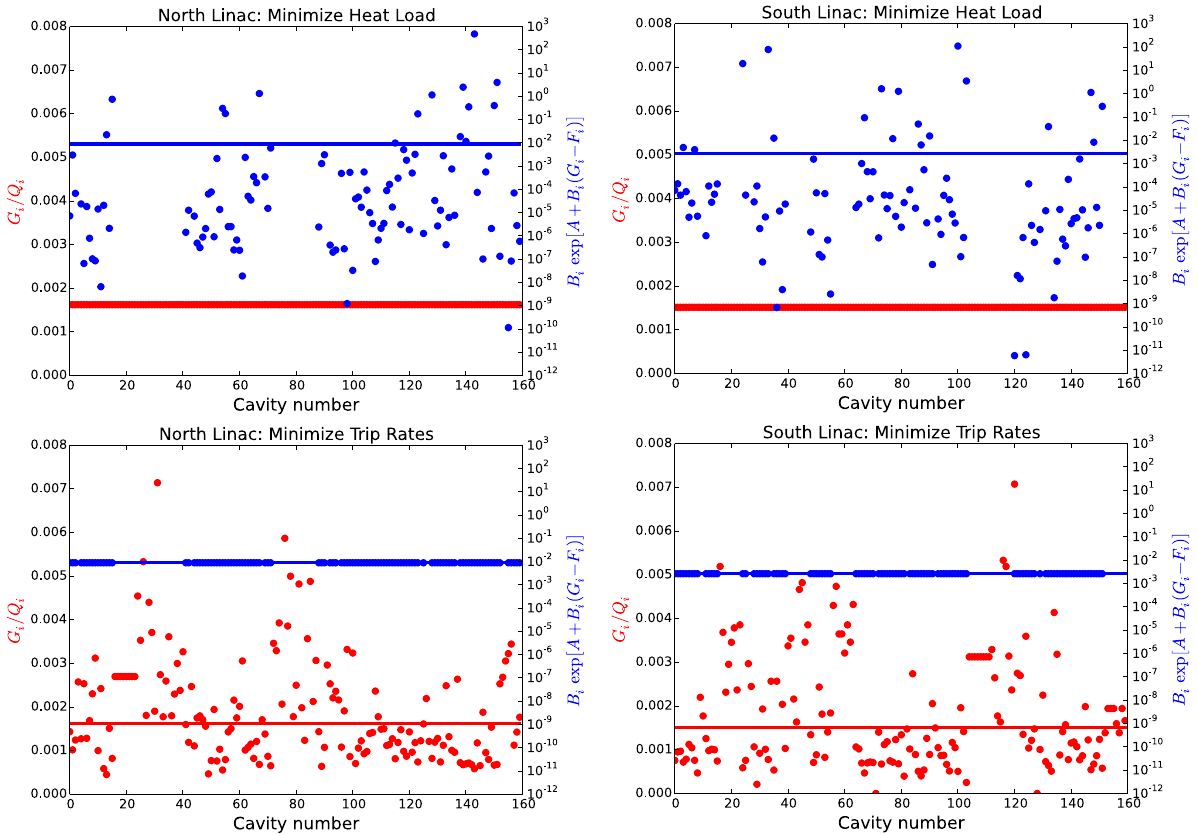
FIG. 1. Plots of the two conserved quantities given in Eq. (8) — G i =Q i shown in red and B i exp ½ A þ B i ð G i − F i Þ(cid:2) shown in blue — for the heat load only minimization (top row) and the trip rate minimization (bottom row) for the CEBAF ’ s North Linac (left column) and South Linac (right column). Solid lines represent the analytically computed values of the conserved